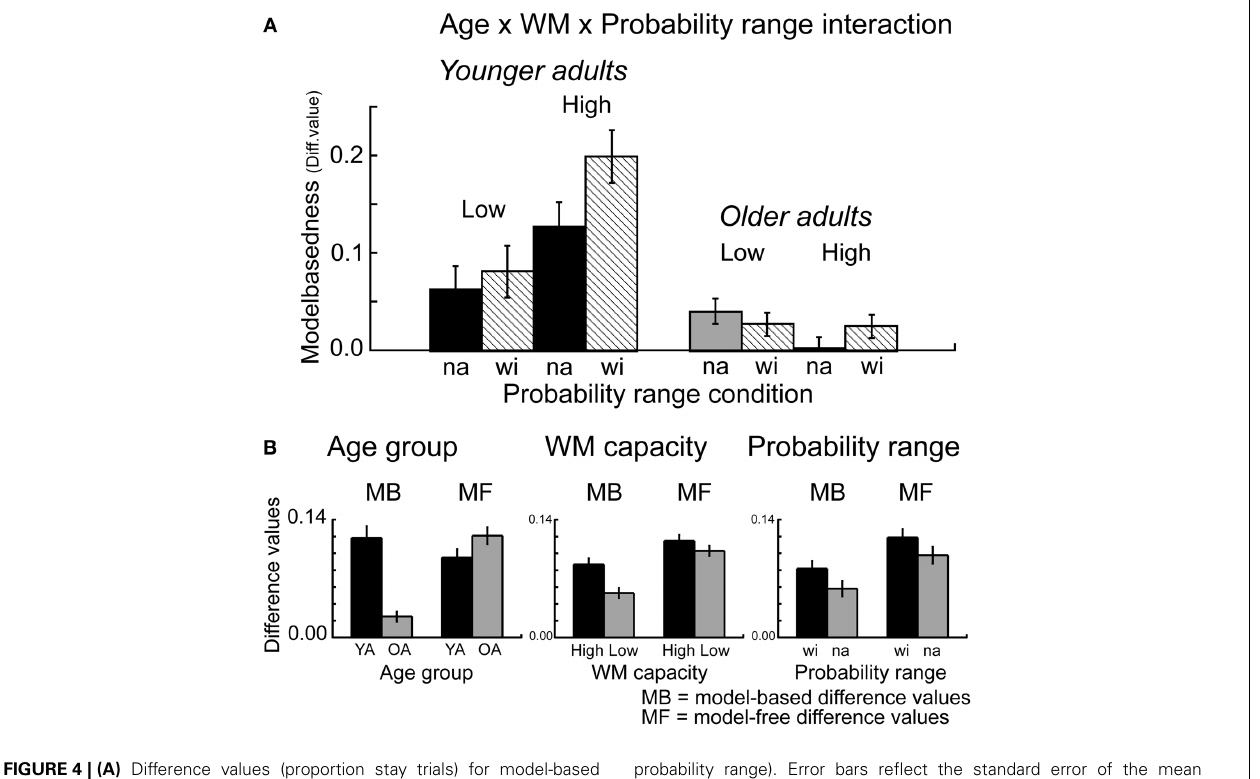
probability range). Error bars reflect the standard error of the mean (s.e.m.). (B) Model-based (MB) and model-free (MF) differences values, displayed separately for the factors Age group, WM capacity and Probability range condition. Error bars reflect the standard error of the mean